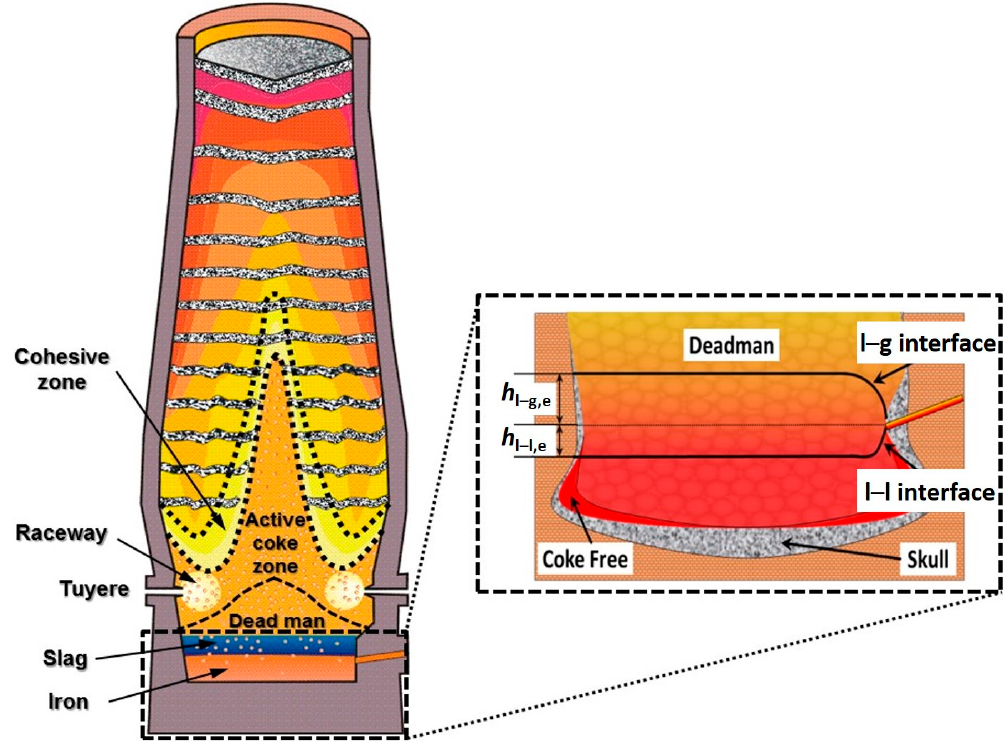
Figure 1. Schematic vertical cross-section of the blast furnace. l–g interface: slag–gas interface; l–l interface: slag–iron interface; h l–l,e : final level of the horizontal part of the l–l interface; h l – g,e : final level of the horizontal part of the l–g interface.